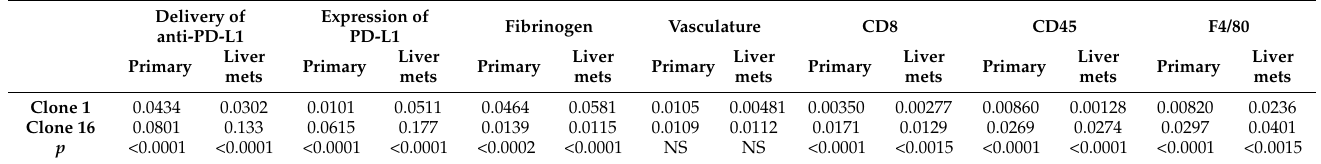
Table 1. Comparison of area fraction between Clone-1- and Clone-16-derived primary tumor and liver metastases. Delivery of anti-PD-